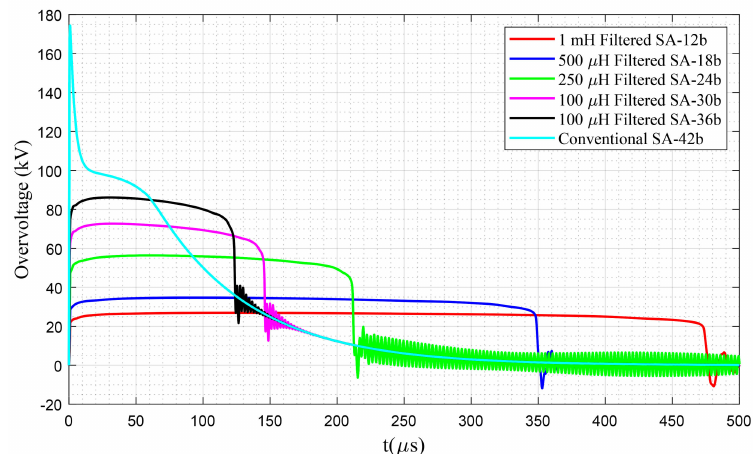
Figure 26. Comparison of the overvoltage stress of MV transformer protected by di ff erent configurations of surge arresters against the 200 kV lightning impulse.